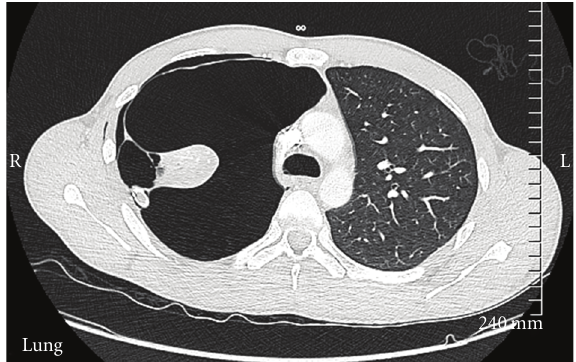
Figure 2: Chest CT showing bullous disease.